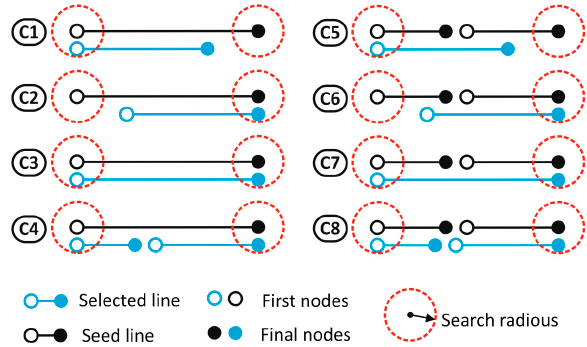
Figure 4. Possible cases (C1–C8) for positive line/s selection from seed line/s. In Cases (C1–C4), the seed line is a single line. In Cases (C5–C8), the selection is performed from double seed lines.